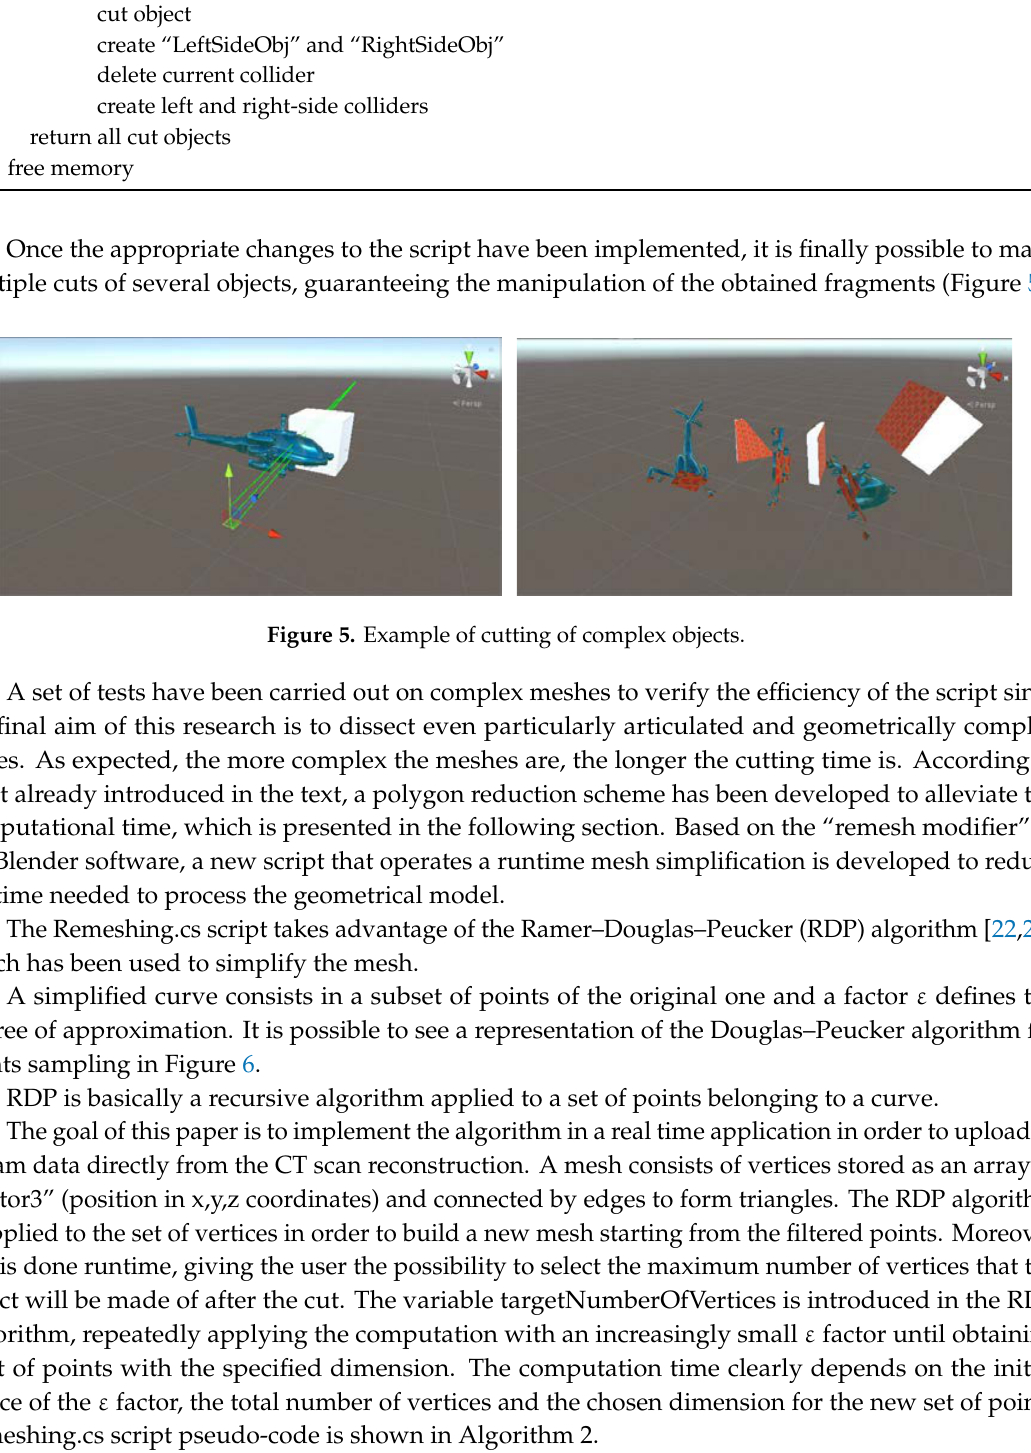
Figure 6. Interpolation strategies following Douglas–Peucker .